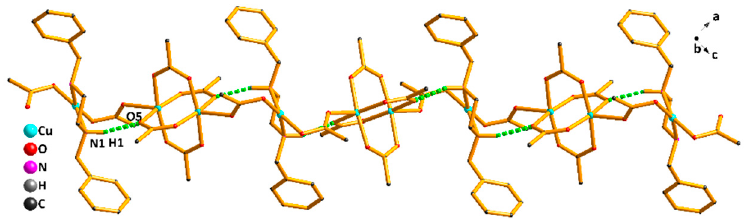
Figure 2. The 1D chain structure of compound ( 1 ).